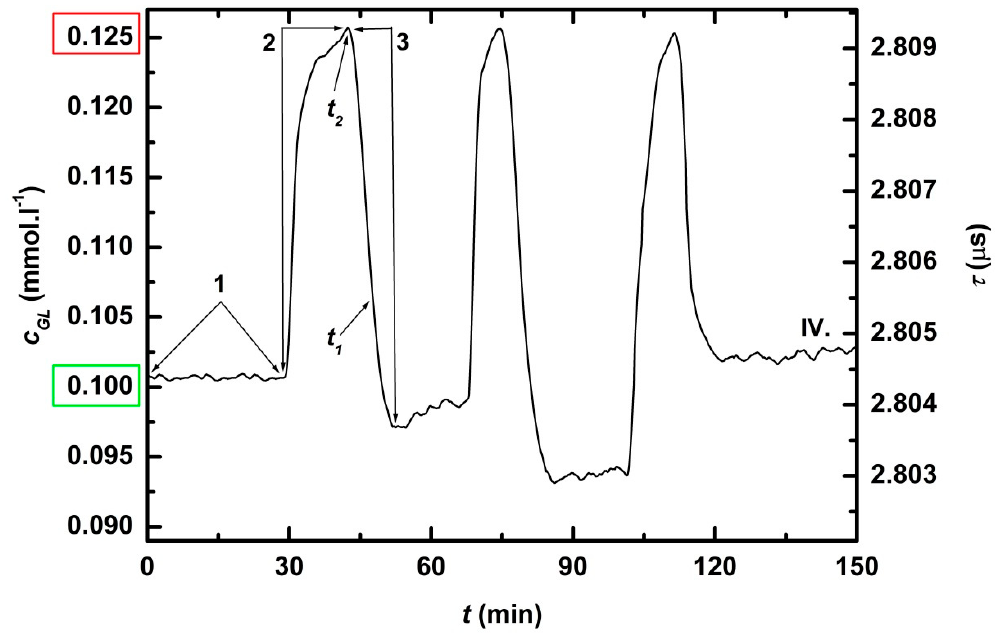
Figure 4. Time record of the feedback regulation of lower glucose concentration (dilution with buffer, test IV). After the initial three t chec (position 1), the concentration of glucose increased from c GLDES = 0.100 mM to c GLMAX = 0.125 mM by hand pipetting of concentrated glucose solution into the bioreactor (position 2). After c GLMAX detection, the pump of feedback loop dosed buffer into the reactor (position 3). t 1 is the time when actual measured glucose concentration exceeded glucose concentration after regulation for 10% and t 2 is time when buffer was added. Table 2. Response times of the biosensor and deviations from desired glucose concentration in case of step increase of glucose concentration.